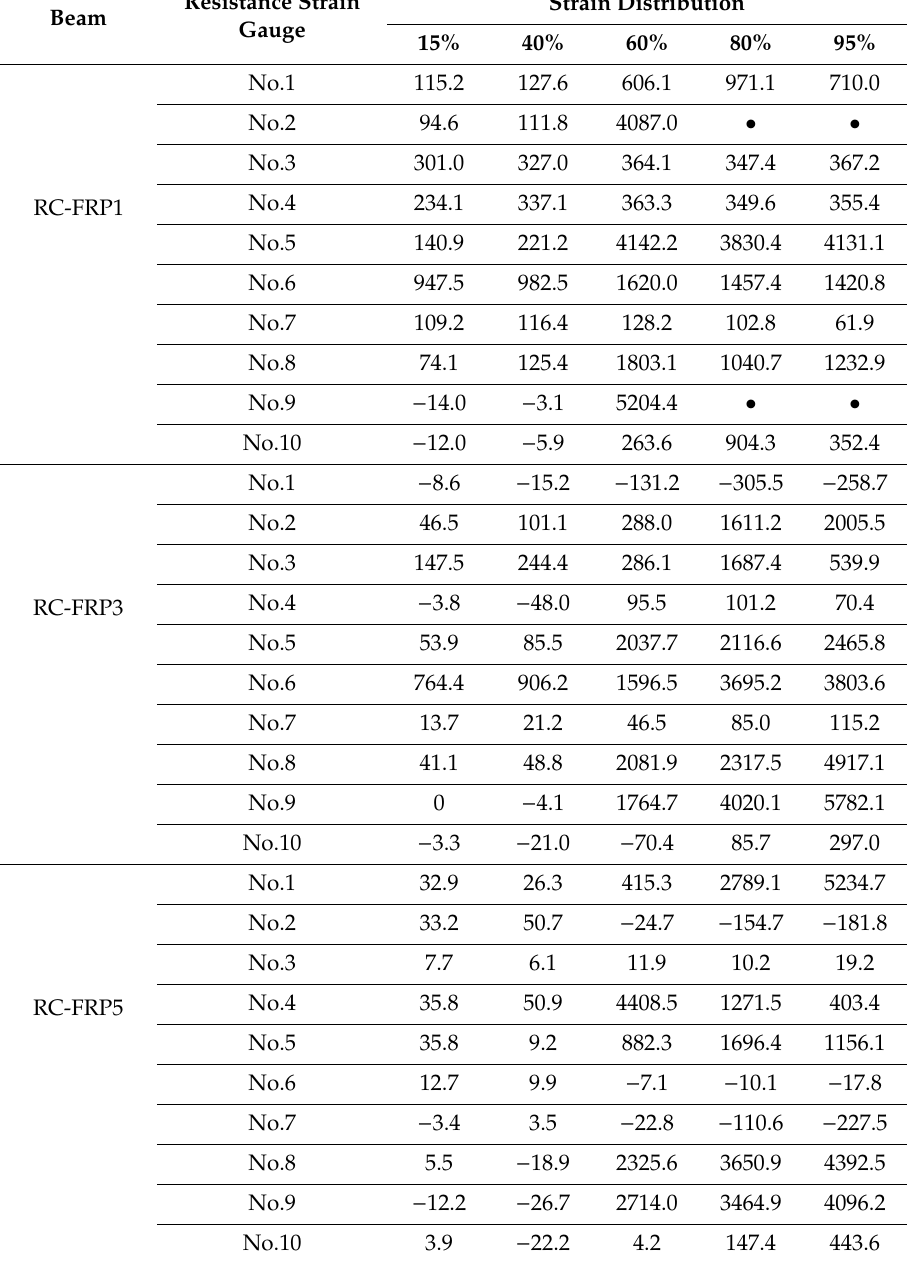
Table 9. Strain distribution of flax fiber sheet for the RC-FRP1, RC-FRP3 and RC-FRP5. Resistance Beam